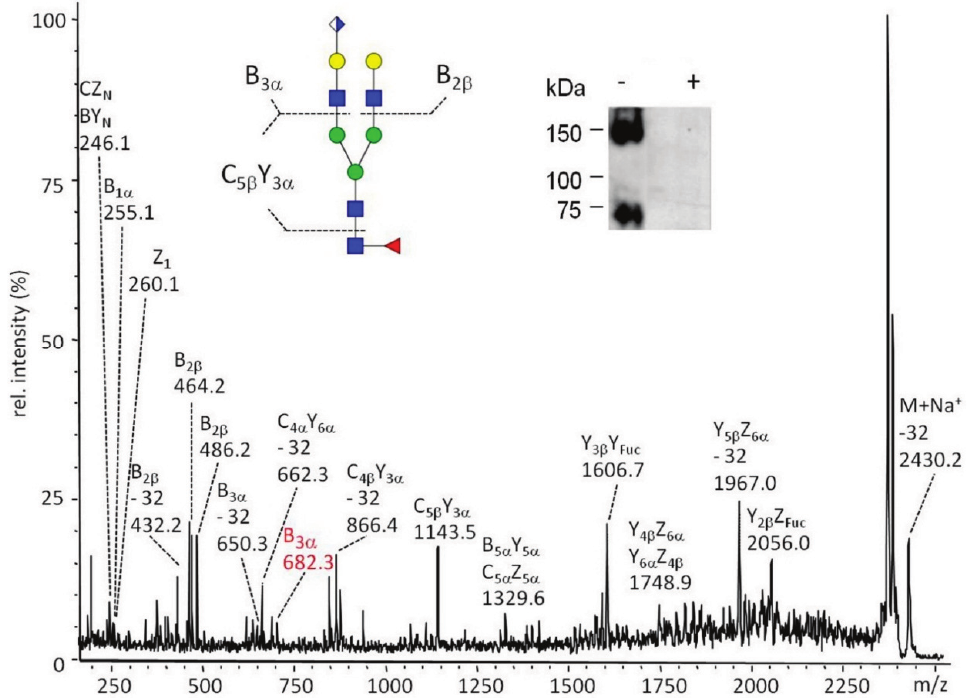
Figure 9. MALDI-MS/MS spectrum of a permethylated N -glycan chain bearing the non-sulfated HNK1-epitope at m / z 2430 (M + Na + ), derived by PNGAseF-digestion of Nid1 coexpressed with dGlcAT-P in CHO-Lec2 cells. The glucuronylated glycan as well as part of the fragments were detected with a mass incremental loss of 32 Da, corresponding to the elimination of methanol. The presence of terminal GlcA is indicated by B series ions (B3 α and B3 α -32) and by double fragmentation ions (B3 α Y5 α )).